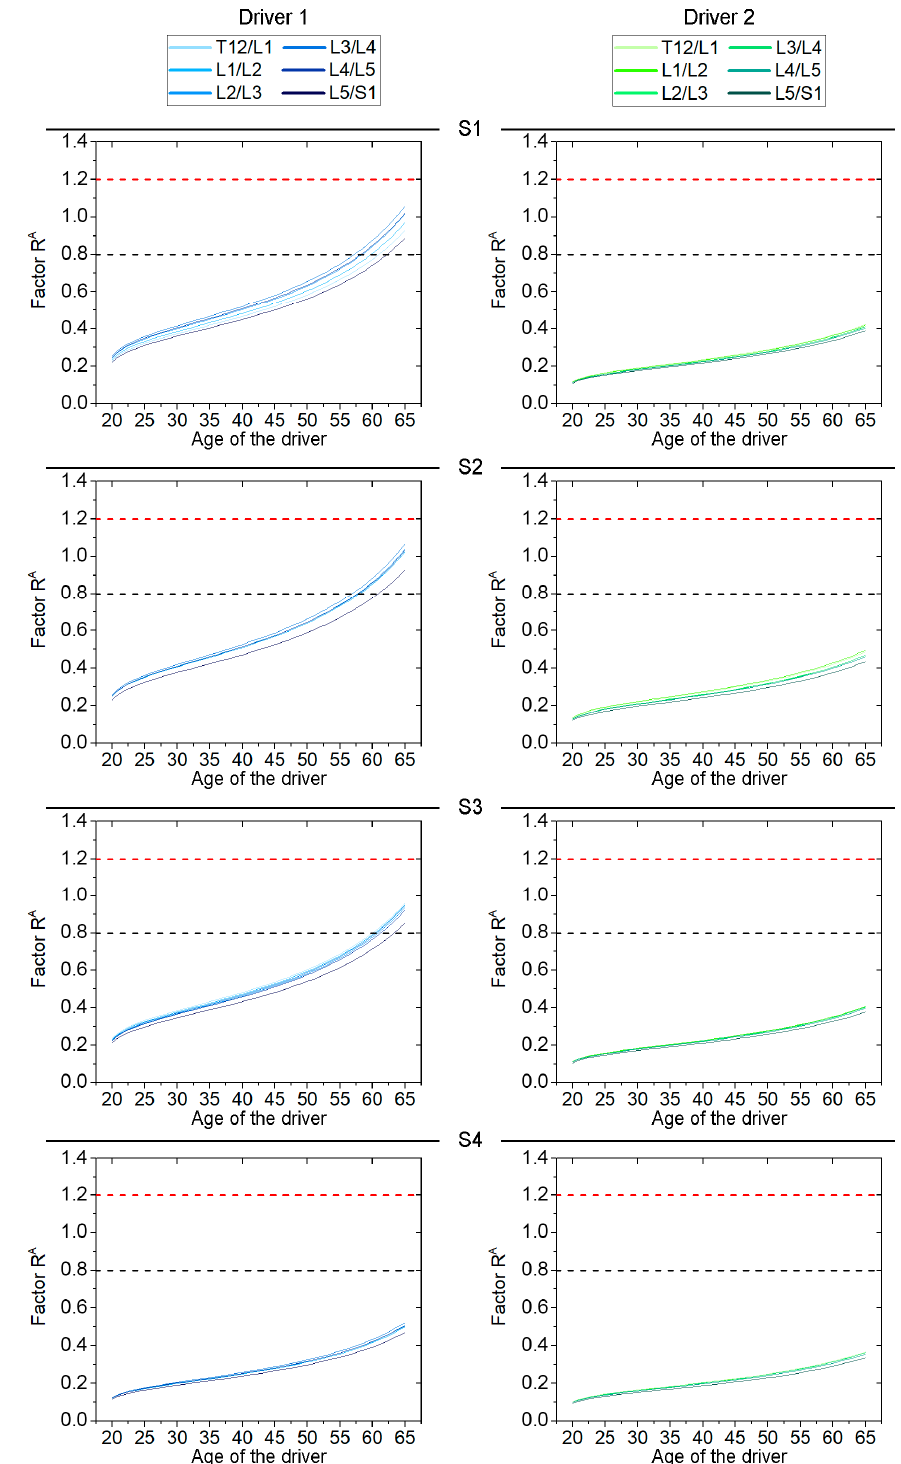
Figure 4. Evolution of the Factor R A at each disc level of the lumbar spine and for each type of surface. Dashed black line indicates low risk probability limit. Dashed red line indicates high probability limit.